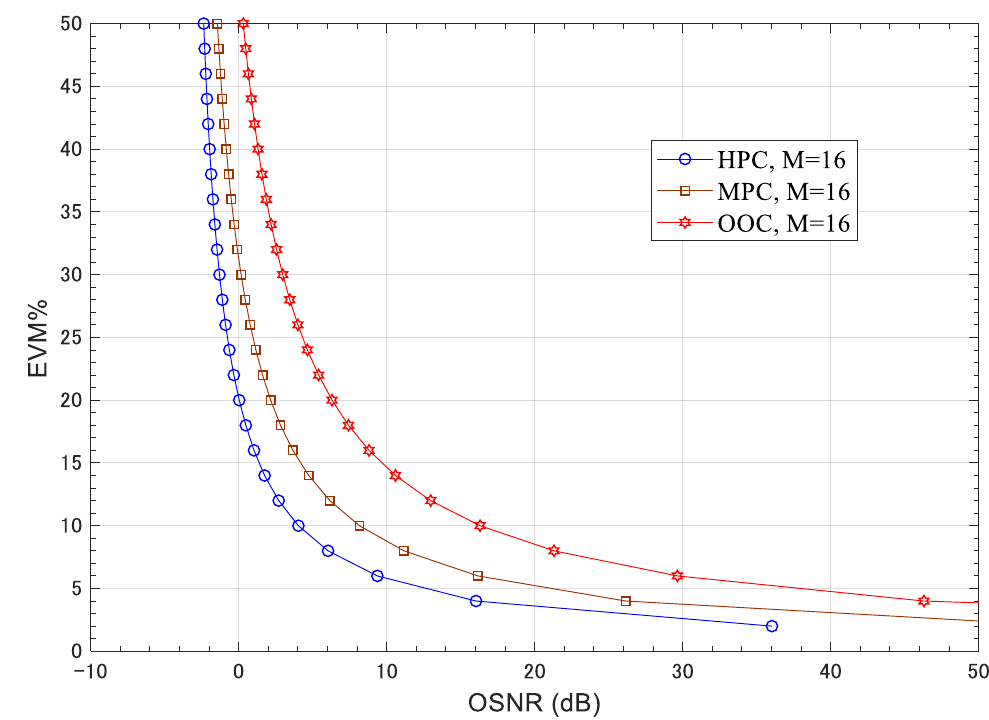
Figure 24. EVM% versus the OSNR for different coding schemes when M = 16.